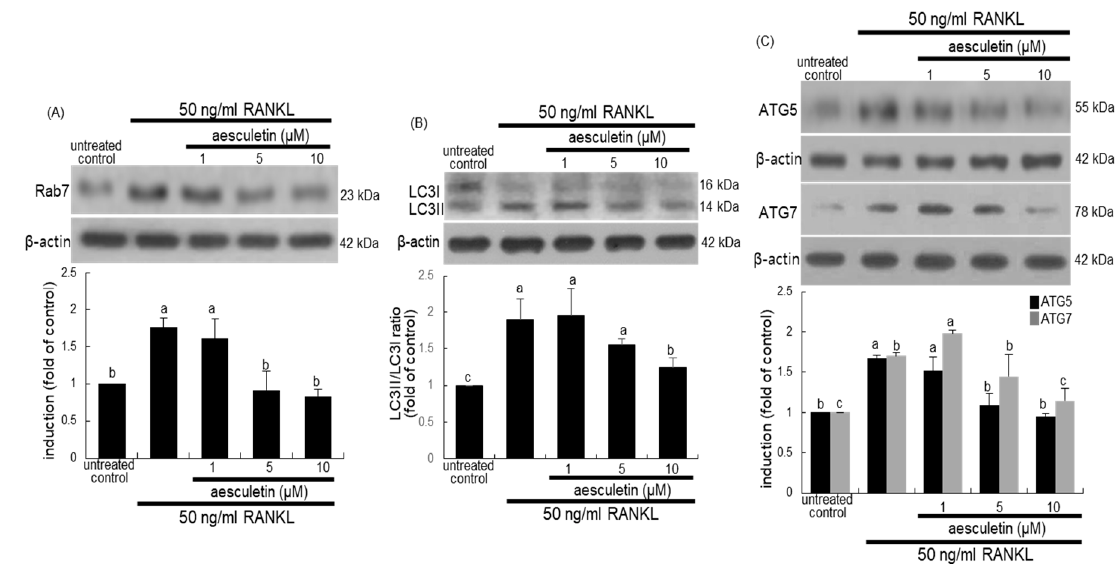
Figure 8. Western blot data showing inhibition of induction of Rab7 ( A ), microtubule-associated protein light chain 3 (LC3) ( B ), Atg5, and Atg7 ( C ) by aesculetin. Raw 264.7 cells were cultured for 5 days with 50 ng / mL RANKL in the absence or presence of 1–10 µ M aesculetin. Whole-cell lysates were subject to SDS-PAGE and Western blot with a primary antibody against Rab7, LC3, Atg5, and Atg7. β -Actin was used as an internal control. The bar graphs (mean ± SEM, n = 3) represent quantitative results of blots obtained from a densitometer. Respective values in double-bar graphs not sharing a letter are significantly di ff erent at p < 0.05.